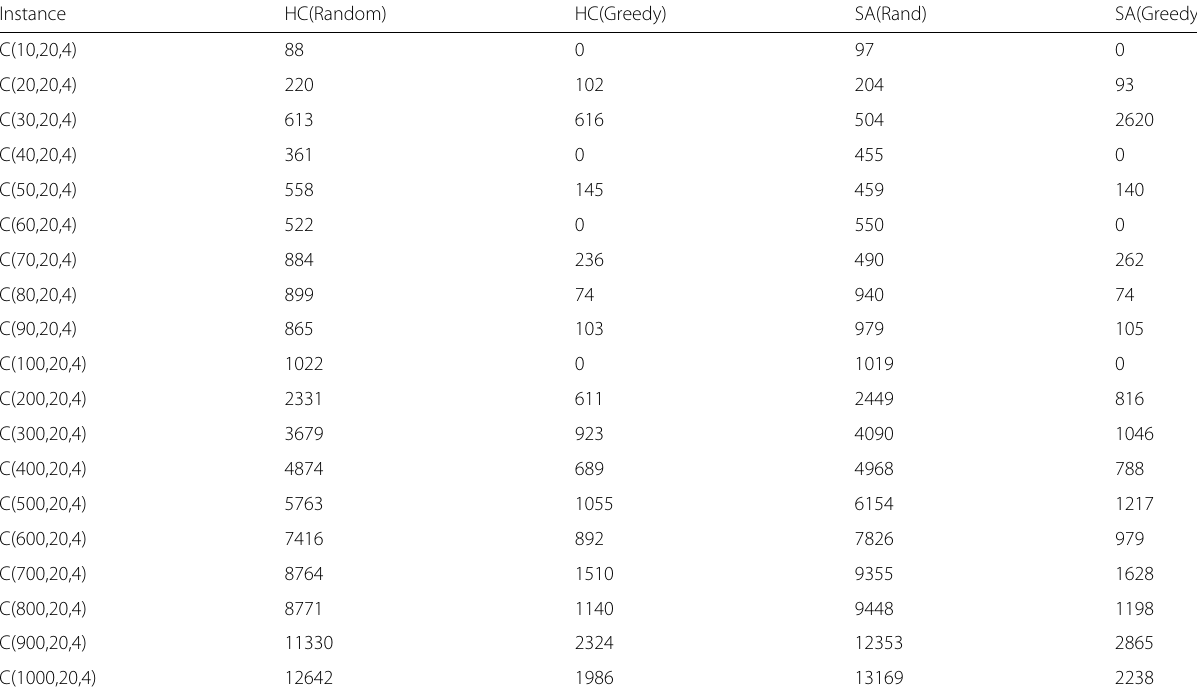
Table 10 Function Evaluations to attain the target solution ( N =